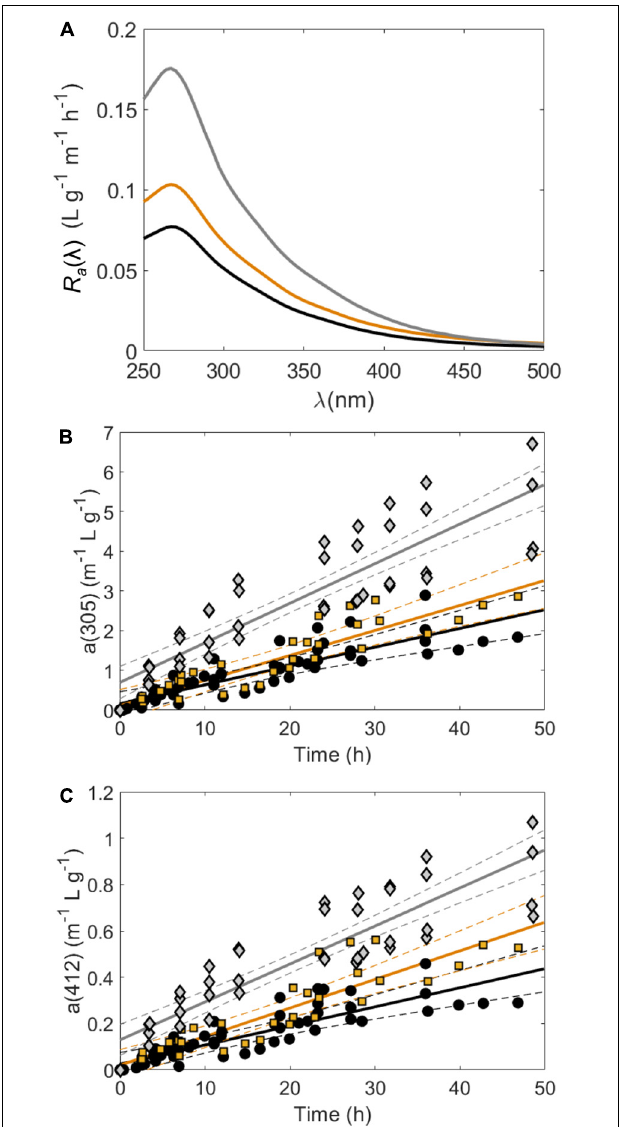
FIGURE 1 | (A) Pooled CDOM absorption coefficient release rates [ R a ( λ ) , a norm ( λ ) h − 1 , Eq. 2] for incubation experiments at each wavelength where the black line corresponds to samples under LED lights or sunlight with a Plexiglas cover (no UV exposure), the orange line corresponds to samples under natural sunlight (with UV exposure) and the gray line corresponds to samples that had no UV exposure but were in mid-senescent conditions. (B,C) show CDOM absorption coefficients normalized to Sargassum mass in wet weight (g) per liter [ a norm ( λ ), m − 1 g − 1 L)] at 305 and 412 nm, respectively, in tanks housing Sargassum over time. Pooled linear regressions (solid lines) with 95% confidence intervals (dashed lines) are shown to highlight the determination of R a values shown in (A) . In (B,C) black circles were under LED lights or sunlight with a Plexiglas cover (no UV exposure), orange squares were under natural sunlight (with UV exposure) and gray diamonds were in mid-senescent conditions.